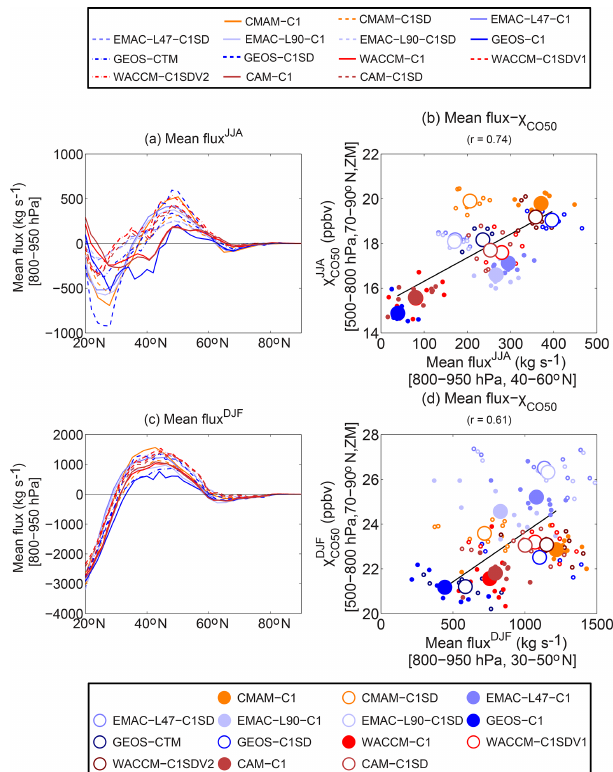
Figure 9. Approximated zonal-mean flux using monthly output: (a, c) latitudinal profile of (cid:104) v χ CO50 (cid:105) (units: kgs − 1 ); (b, d) correla- tion between the zonal-mean flux (vertical average of 800–950hPa, latitudinal average of 40–60 ◦ N during JJA and 30–50 ◦ N during DJF) and the Arctic CO50 concentration (vertical average of 500– 800hPa, latitudinal average of 70–90 ◦ N, and zonal mean (ZM), units: ppbv), during JJA in (a) and (b) and during DJF in (c) and (d)